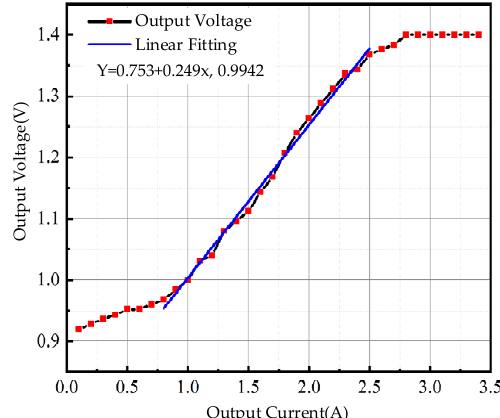
Figure 11. DC response characteristic curve of sensor .